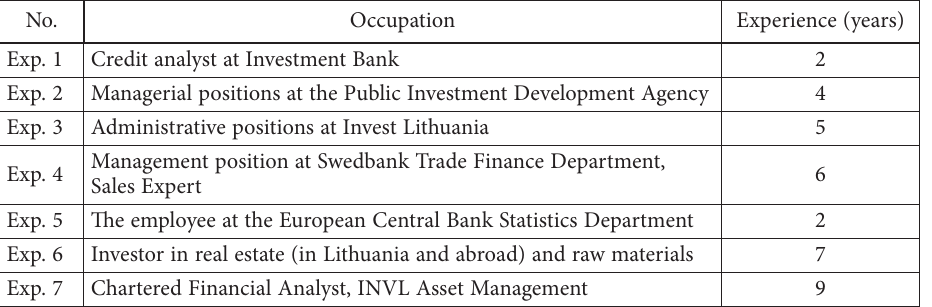
Table 2. Information on the experts involved in the study No.